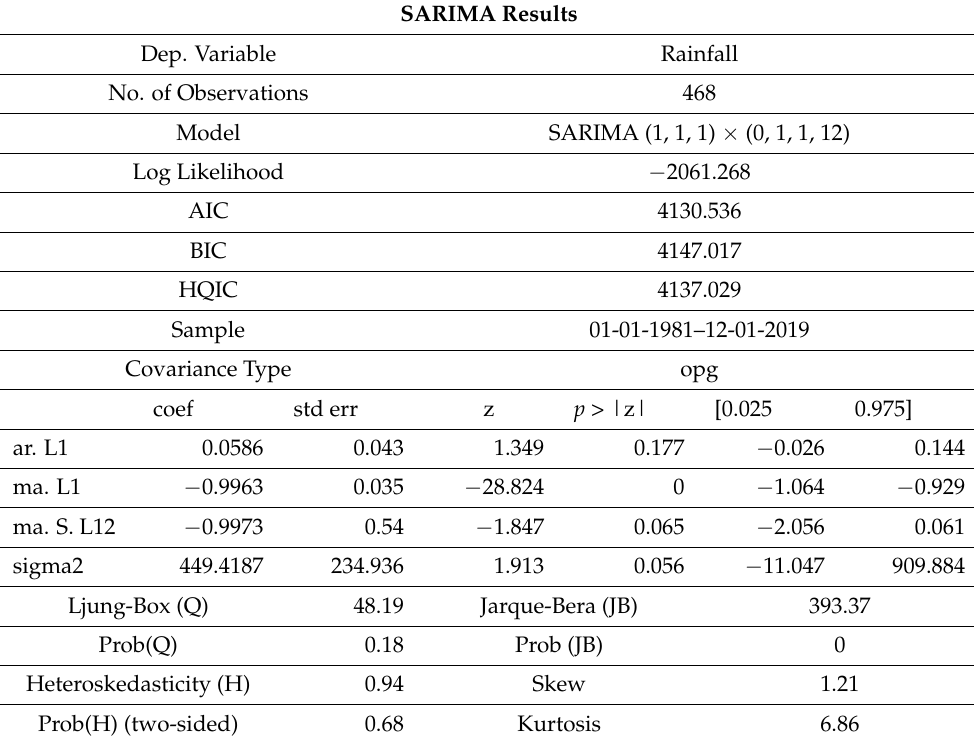
Table 2. Table summary for SARIMA (1,1,1) (0,1,1)12